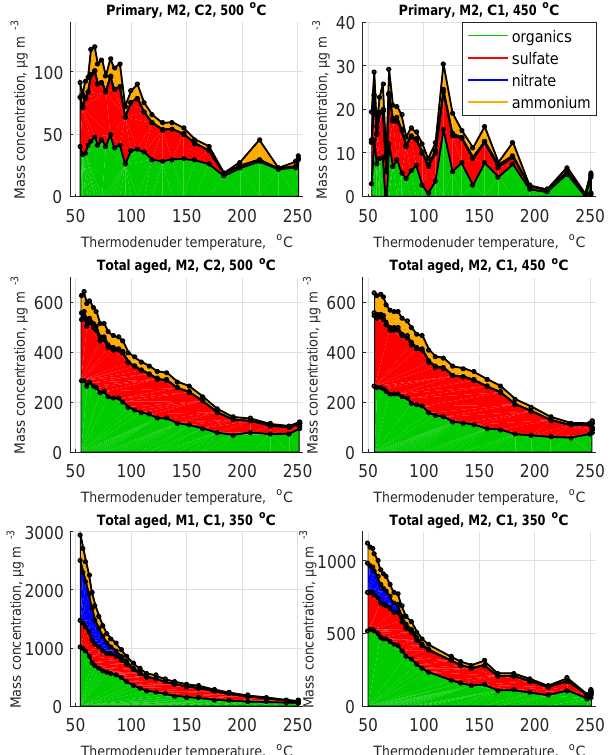
Figure 4. Concentration of different chemical compounds of parti- cles remaining after the thermodenuder treatment conducted for the exhaust aerosol. The mass concentrations were measured using the SP-AMS at different thermodenuder temperatures and corrected by the dilution ratio used in the sampling